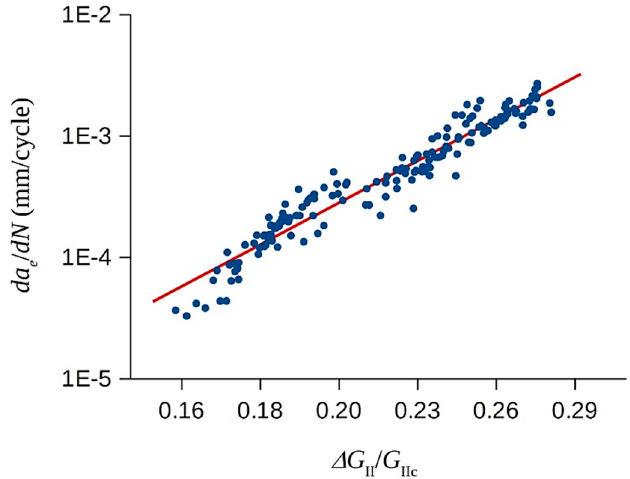
Figure 8. Effective crack propagation rate versus the strain-energy release rate range experimental data points. The fitting with Paris law-type Equation (5) is also shown.